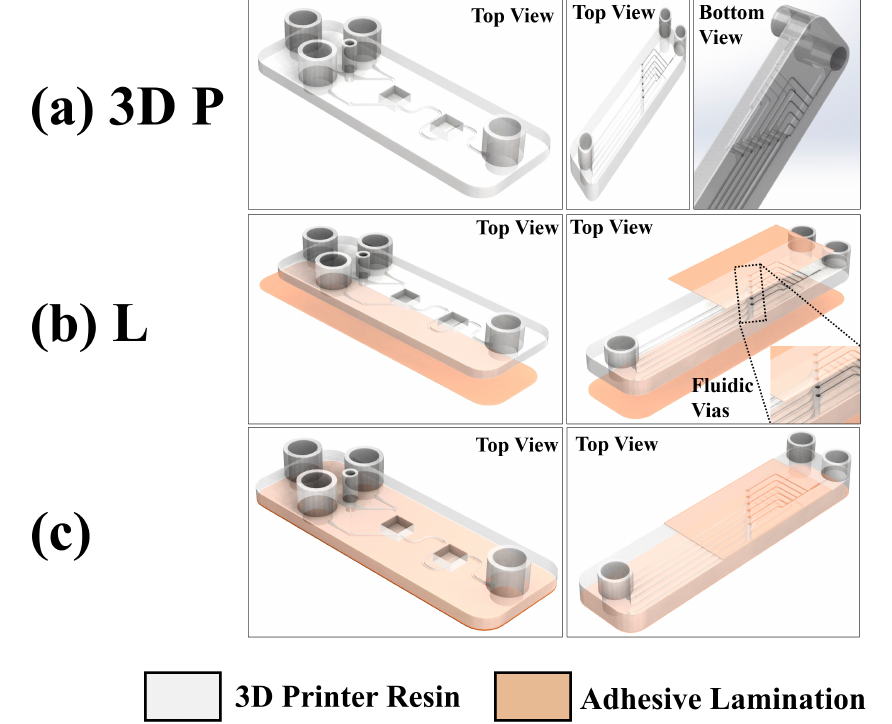
Figure 3. ( a ) 3D design of the microfluidics (MFs) used for 3D printing (3D P); ( b ) lamination (L) with poly ethylene terephthalate (PET)/adhesive to seal the microfluidic channel; ( c ) final fabricated device